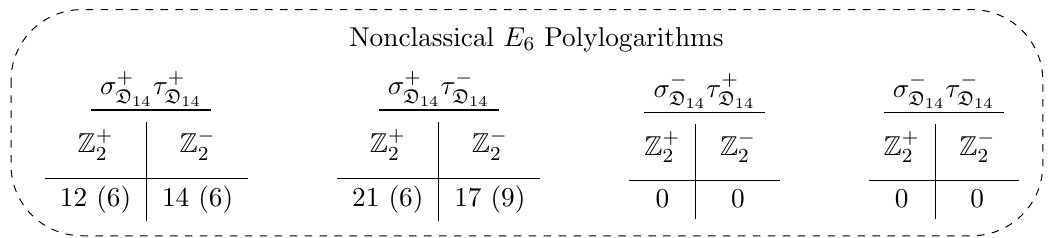
Table 3. The number of nonclassical weight-four cluster polylogarithms on the E with each of eight possible automorphism signatures. The number of functions that additionally respect cobracket-level cluster adjacency is given in